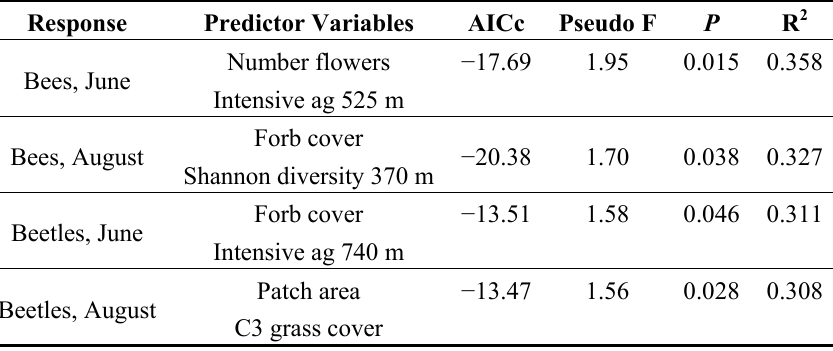
Table 4. Summary of ordinations using distance-based redundancy analysis on the community composition of bees and predatory beetles. The pseudo F-statistic and p -value are based on 999 permutations of the species by sample